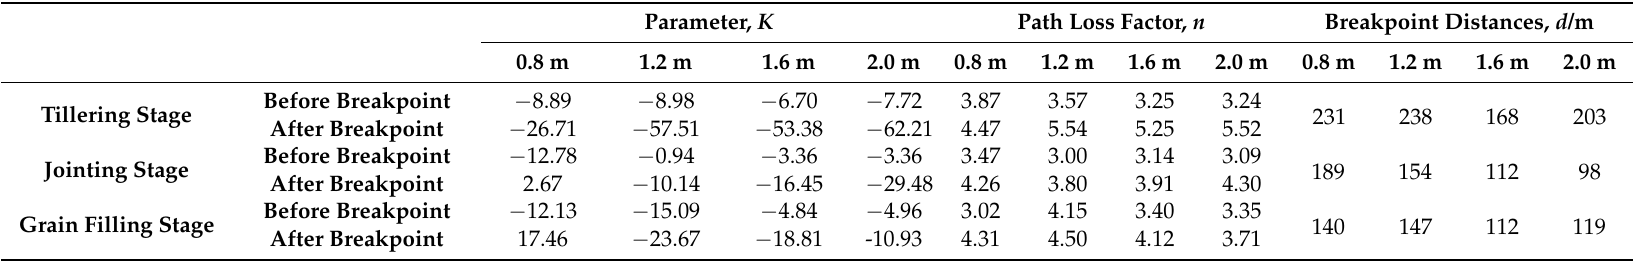
Table 2. Regression parameters of the modified two-slope log-distance